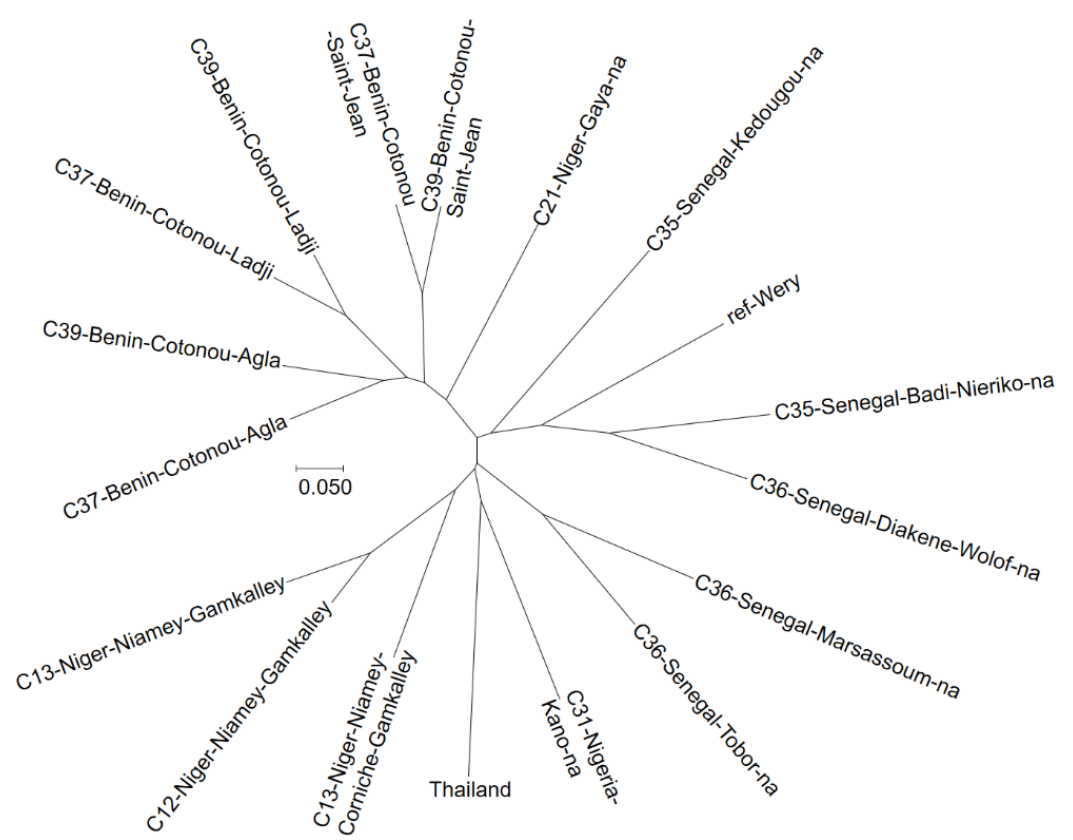
Figure 2: Neighbor-Joining Tree of Trypanosoma lewisi Operative Taxonomic Units (OTUs) from Africa and Thailand with complete genotypes on nine microsatellite loci. OTU's names indicate their cohort number (e.g. C37), their country, town and neighborhood of origin. Number of isolates per OTU can be checked out in Table 1. Thailand was represented by only two individuals, while ref-Wery is a reference strain from Democratic Republic of Congo. The tree was drawn after a Cavalli-Sforza and Edward's chord distance matrix (na: information not